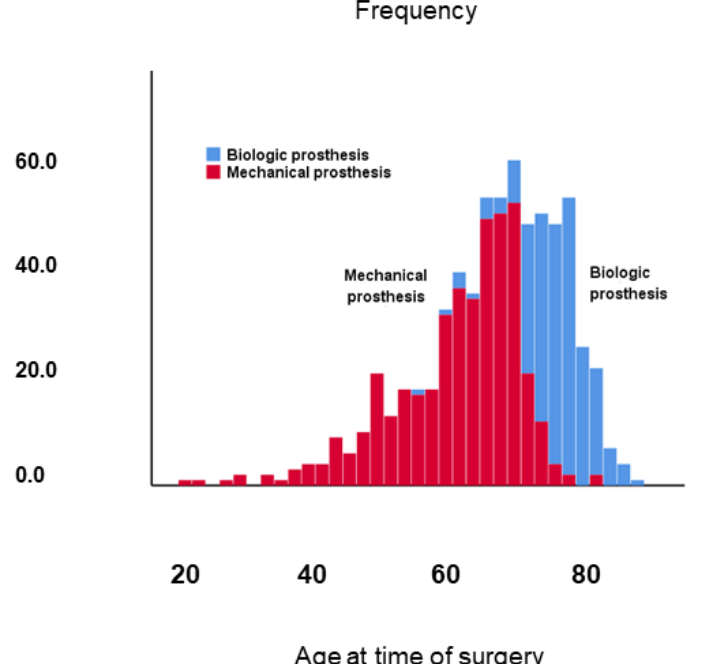
Figure 6. Histogram showing the frequency of patients with a mechanical vs. those with a biologic prosthesis in the total study population of 673 patients.